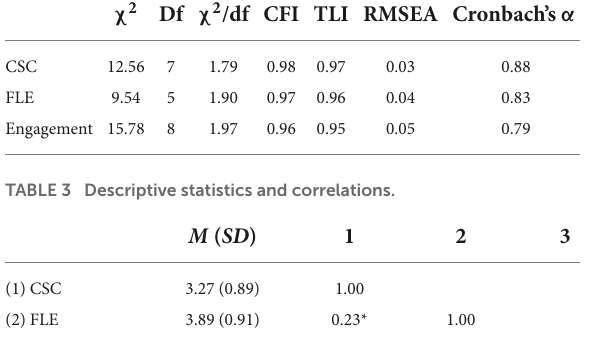
TABLE 2 Measurement model of the latent constructs.